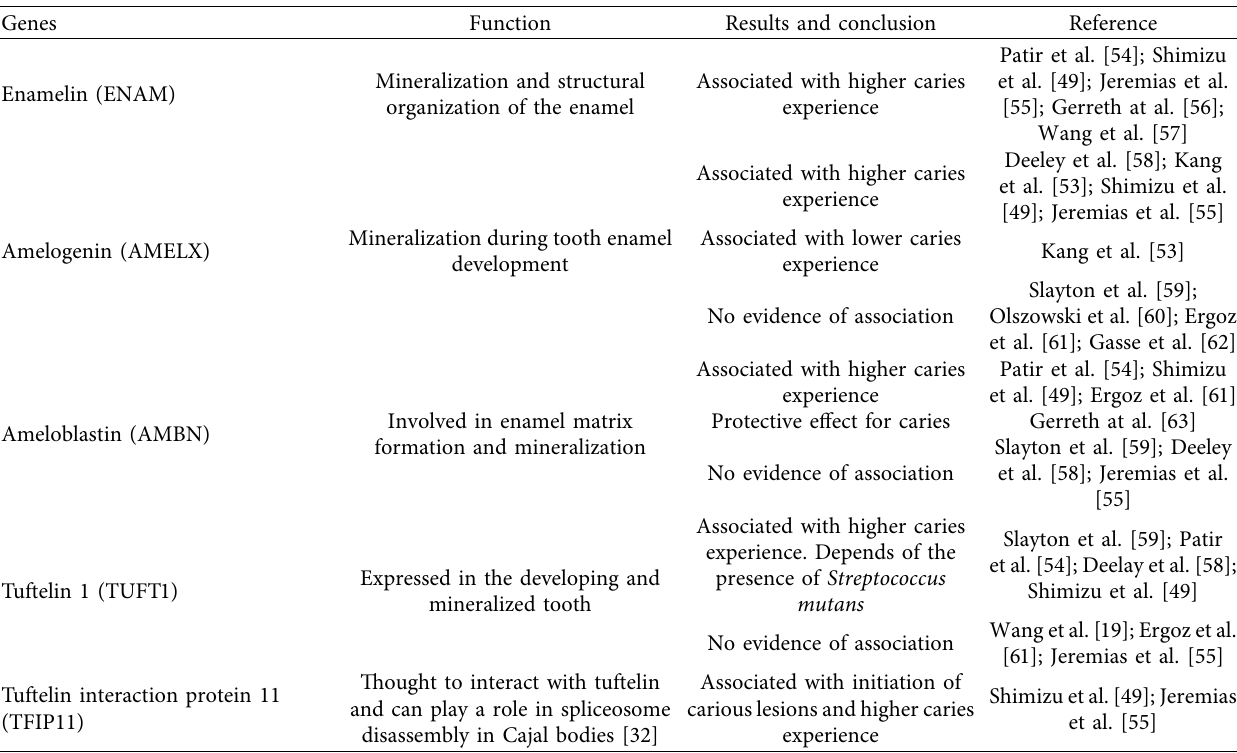
Table 2: Candidate genes studied for dental caries in